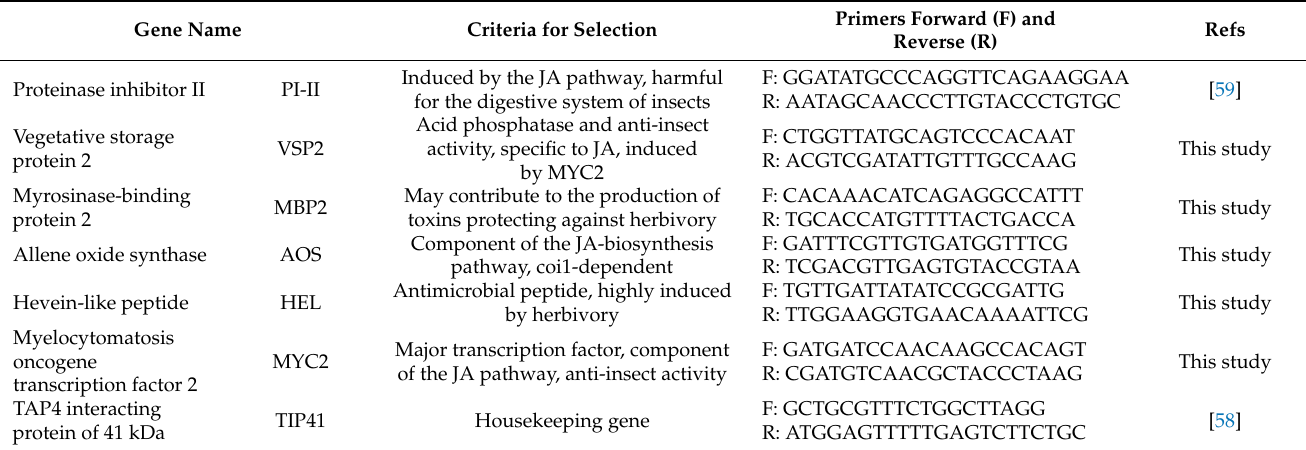
Table 1. Names of the genes with their respective selection criteria and primers